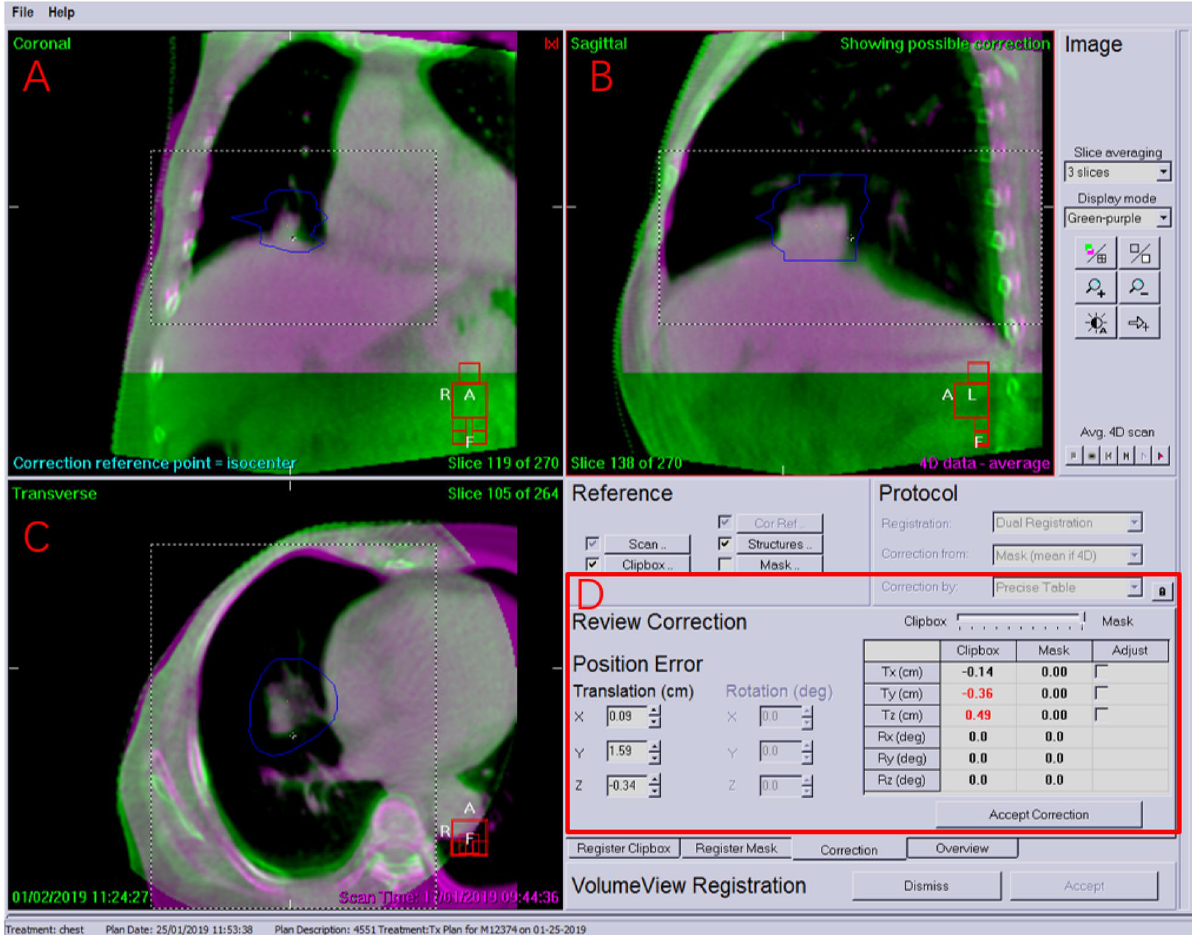
Figure 1. Registration result between reference AvgIP (green color) from 4DCBCT-simulated images and AvgIP (purple color) from 4DCBCT-guided images ( A : Coronal plane, B : Sagittal plane, C : Transverse plane, D : Clipbox and Mask registered